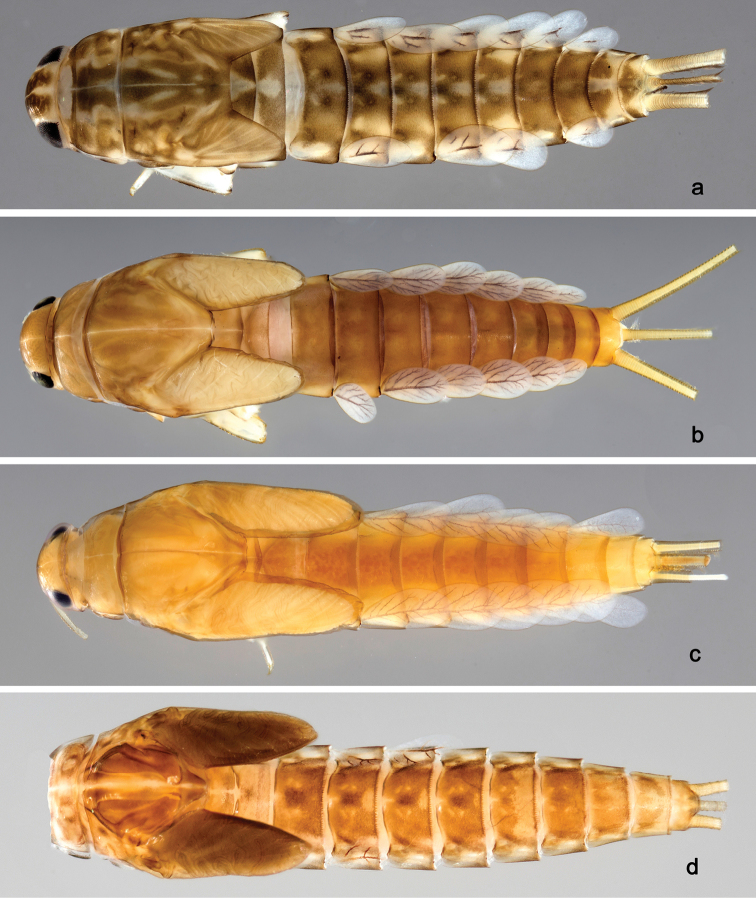
Habitus, larvae: aLabiobaetiscentralensis sp. n., dorsal view bLabiobaetiselisae sp. n., dorsal view cLabiobaetispindaundensis sp. n., dorsal view dLabiobaetisvallus sp. n., dorsal view, without head.